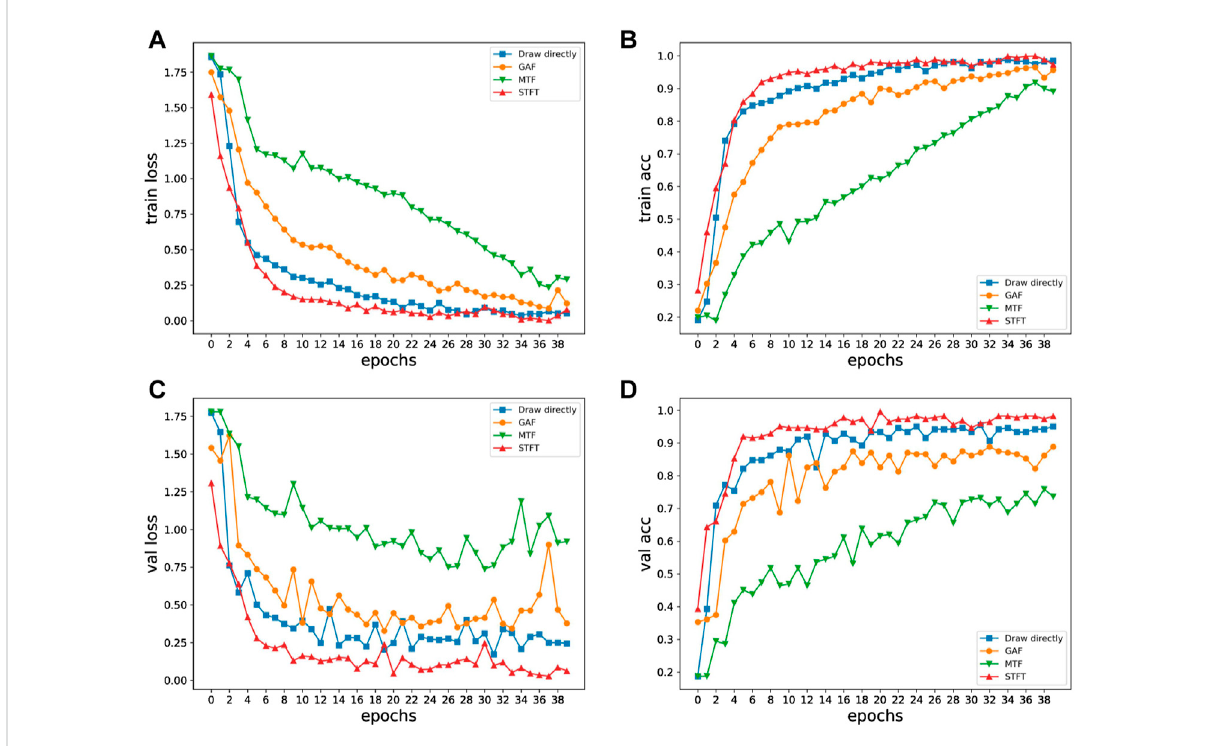
FIGURE 7 Loss and acc curves of four methods: (A) Train loss, (B) Train acc, (C) Val loss, (D) Val